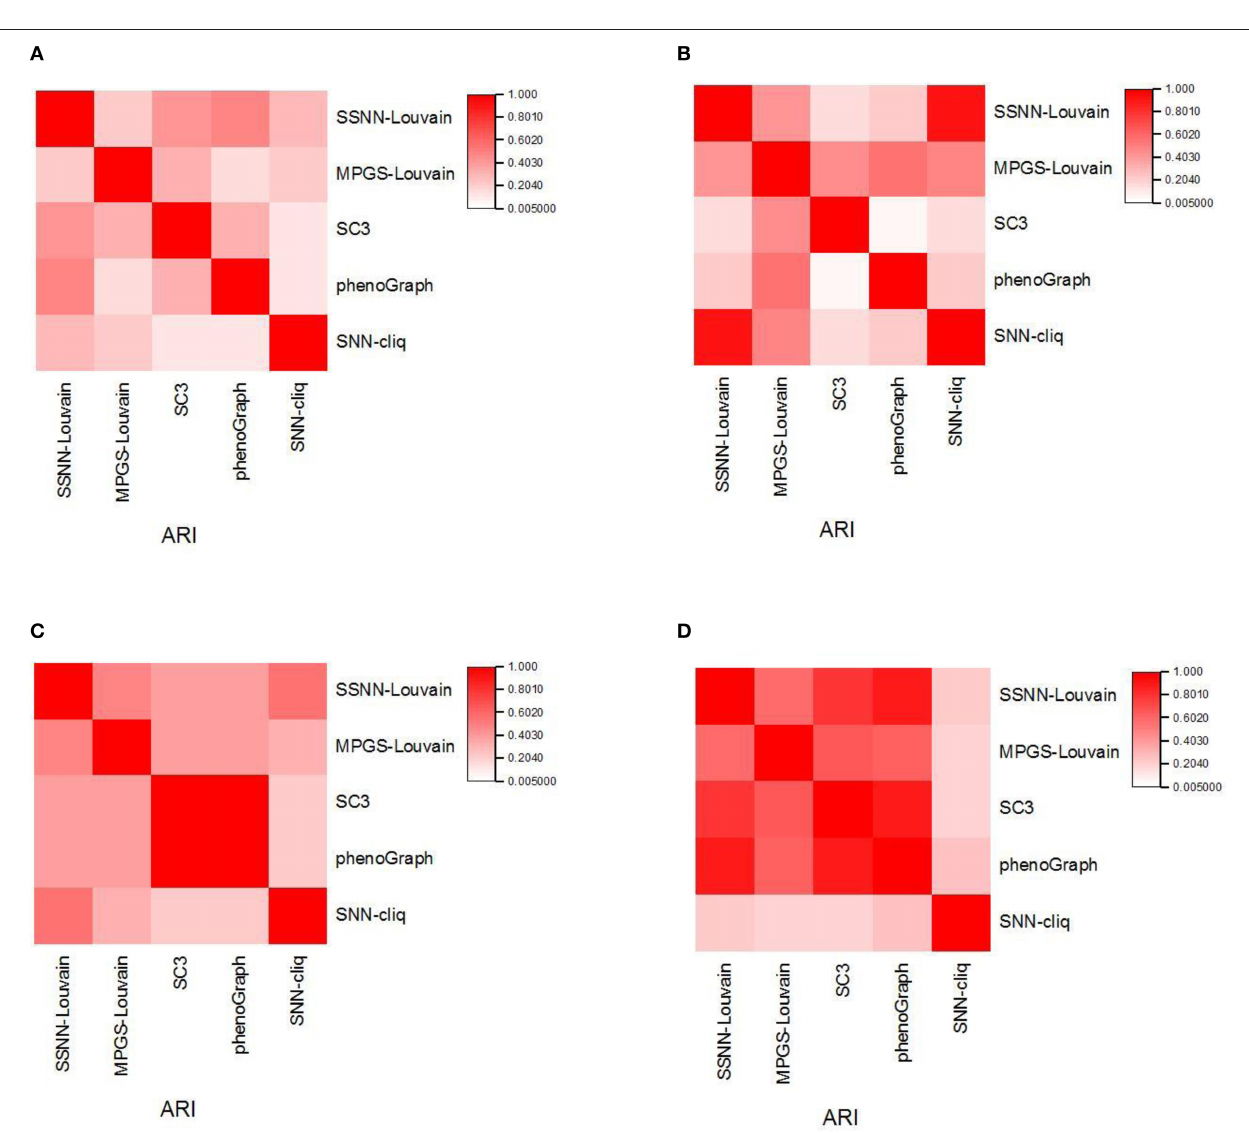
Frontiers in Genetics |